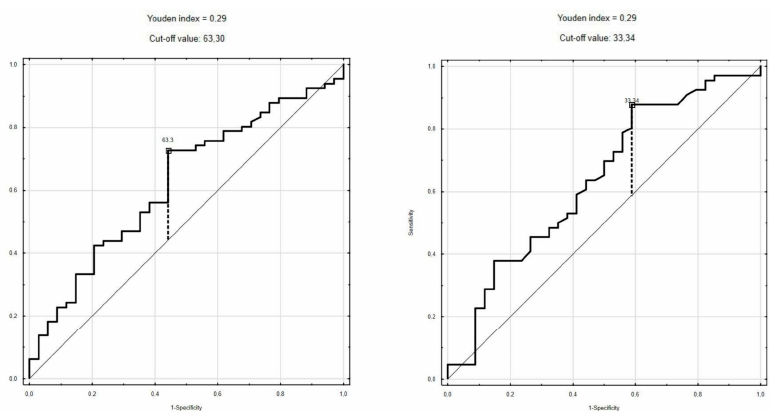
Figure 2. Comparisons of I-TAC-1 and IP-10-1 concentration between groups A and B+C.